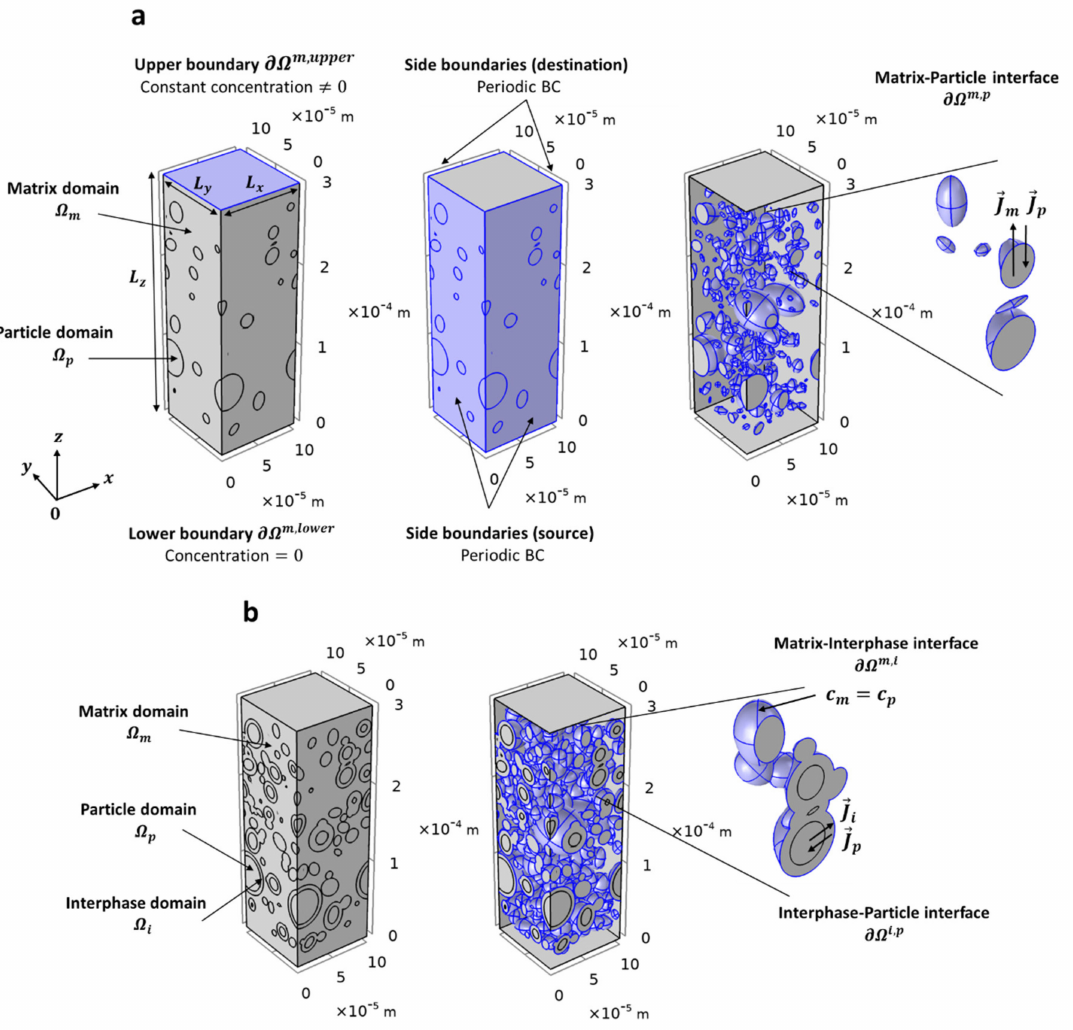
Figure 2. Representation of the RVE showing: ( a ) the boundaries conditions at the six composite faces and at the interface matrix–particle for a two–phase structure; ( b ) the boundaries conditions at the matrix–interphase and interphase–particle interfaces for a three–phase